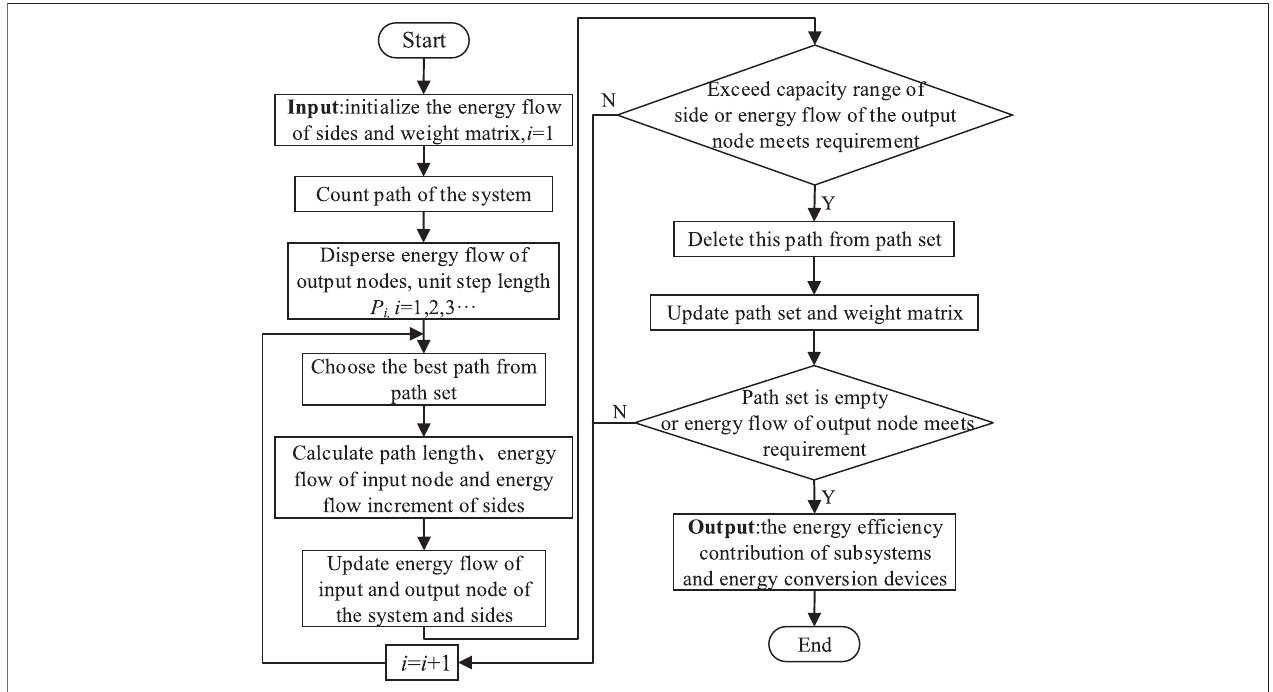
FIGURE 3 | Calculation steps based on the weighted directed